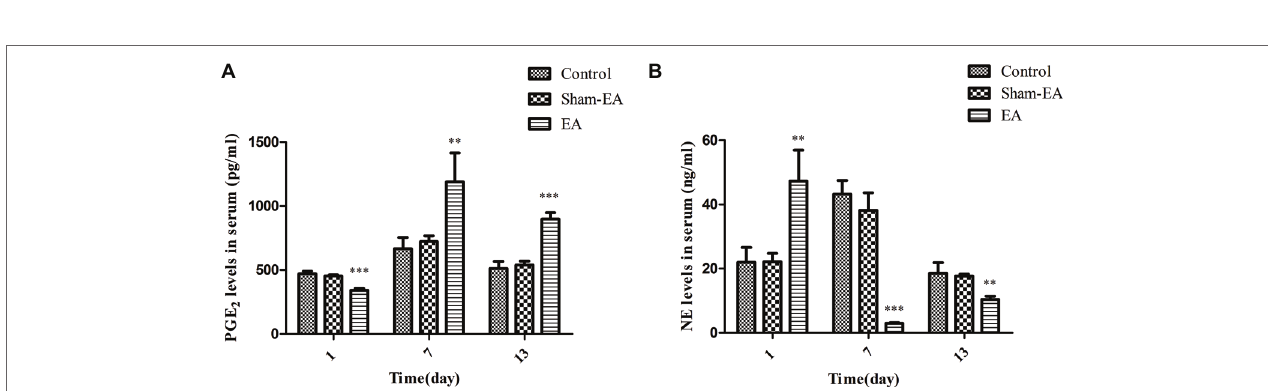
FIGURE 5 | Serum PGE 2 and NE levels at day 1, 7, and 13 after EA treatment. (A) PGE 2 levels in serum. (B) NE levels in serum. Data are presented as means ± SD. * indicates the changes of the hormone levels are different between the EA-treated rats and the Control or Sham-EA rats, ** p < 0.01, *** p <